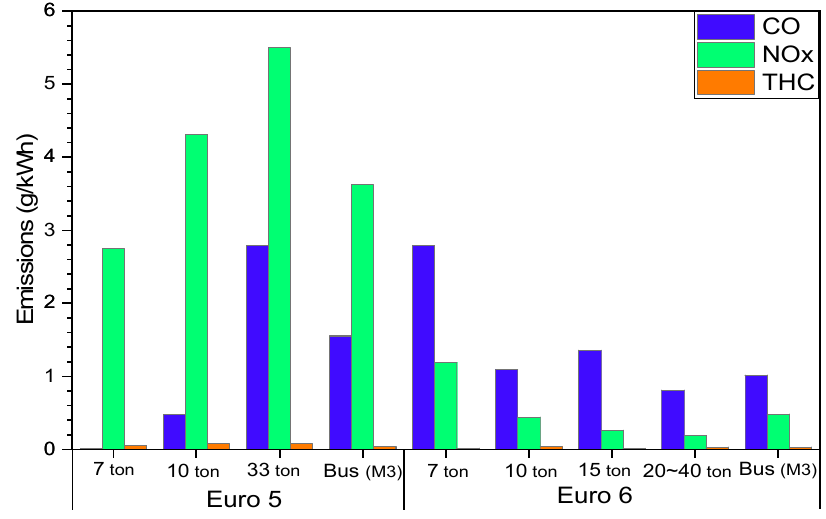
Figure 3. Specific on-road emissions from Euro 6 heavy-duty vehicles in comparison with Euro 5 tested vehicles of trucks and buses. Vehicles are categorized on the basis of their GVWs.